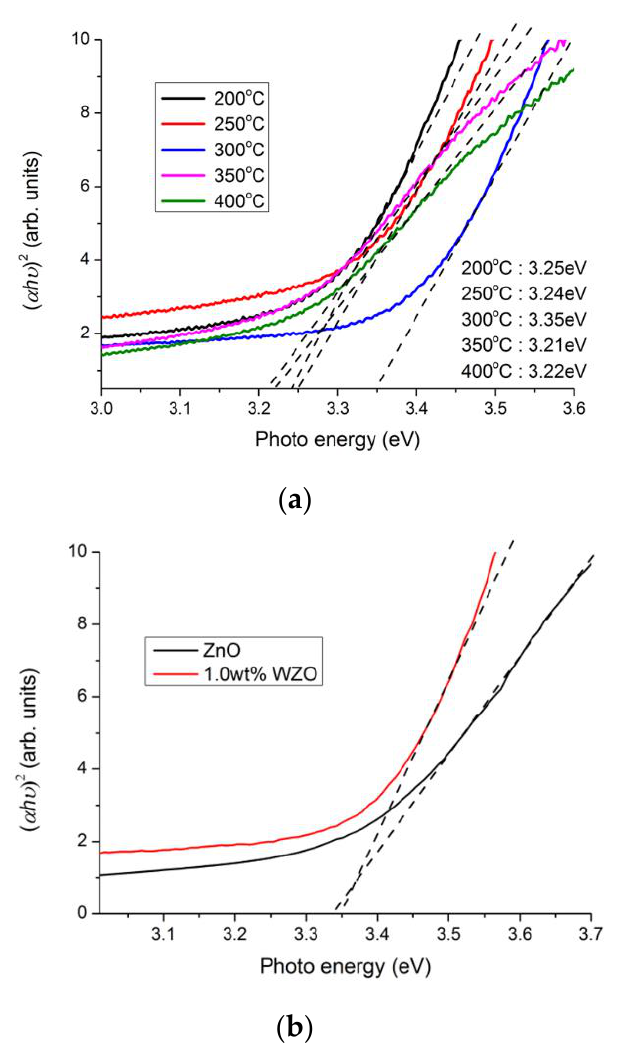
Figure 9. ( a ) Bandgaps of 1.0 wt.% WZO films deposited under different growth temperatures (200 – 400 °C). ( b ) Bandgap comparison between ZnO and 1.0 wt.% WZO films grown at 300 °C.